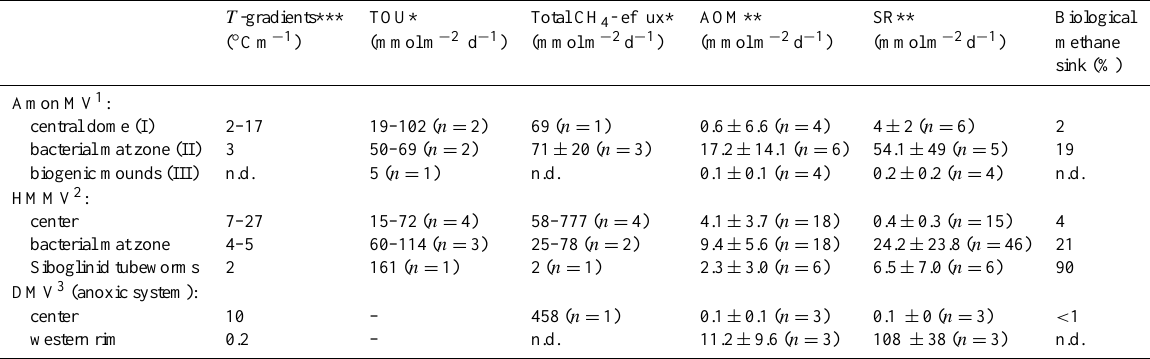
Table 2. Comparison of total oxygen uptakes (TOU), methane effluxes, SR rates, and temperature surface and subsurface gradients at the Amon MV, H˚akon Mosby MV (HMMV), and Dvurechenskii (DMV). The efficiency of the anaerobic biological methane sink is calculated as the percentage of anaerobic oxidation of methane from the total methane flux (sum of CH 4 efflux and methane